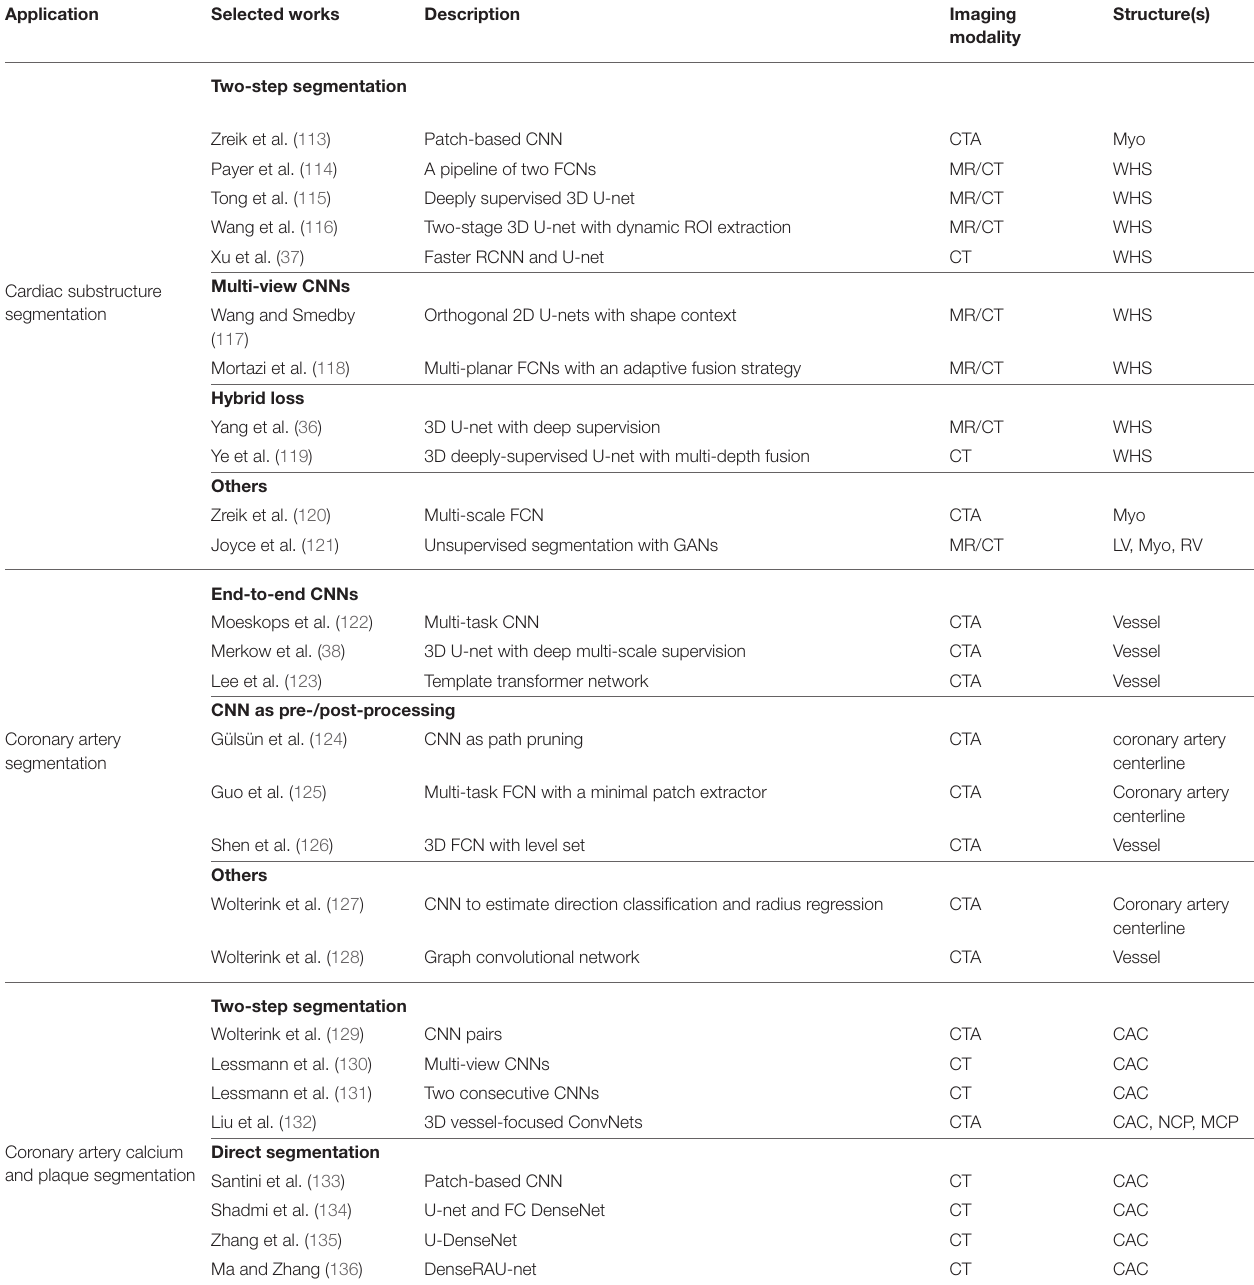
TABLE 3 | A summary of selected deep learning methods on cardiac CT segmentation.